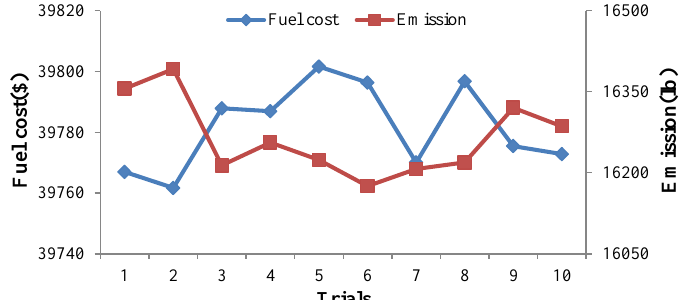
Figure 6. Best compromise solutions obtained by PMOGA in 10 independent trials.